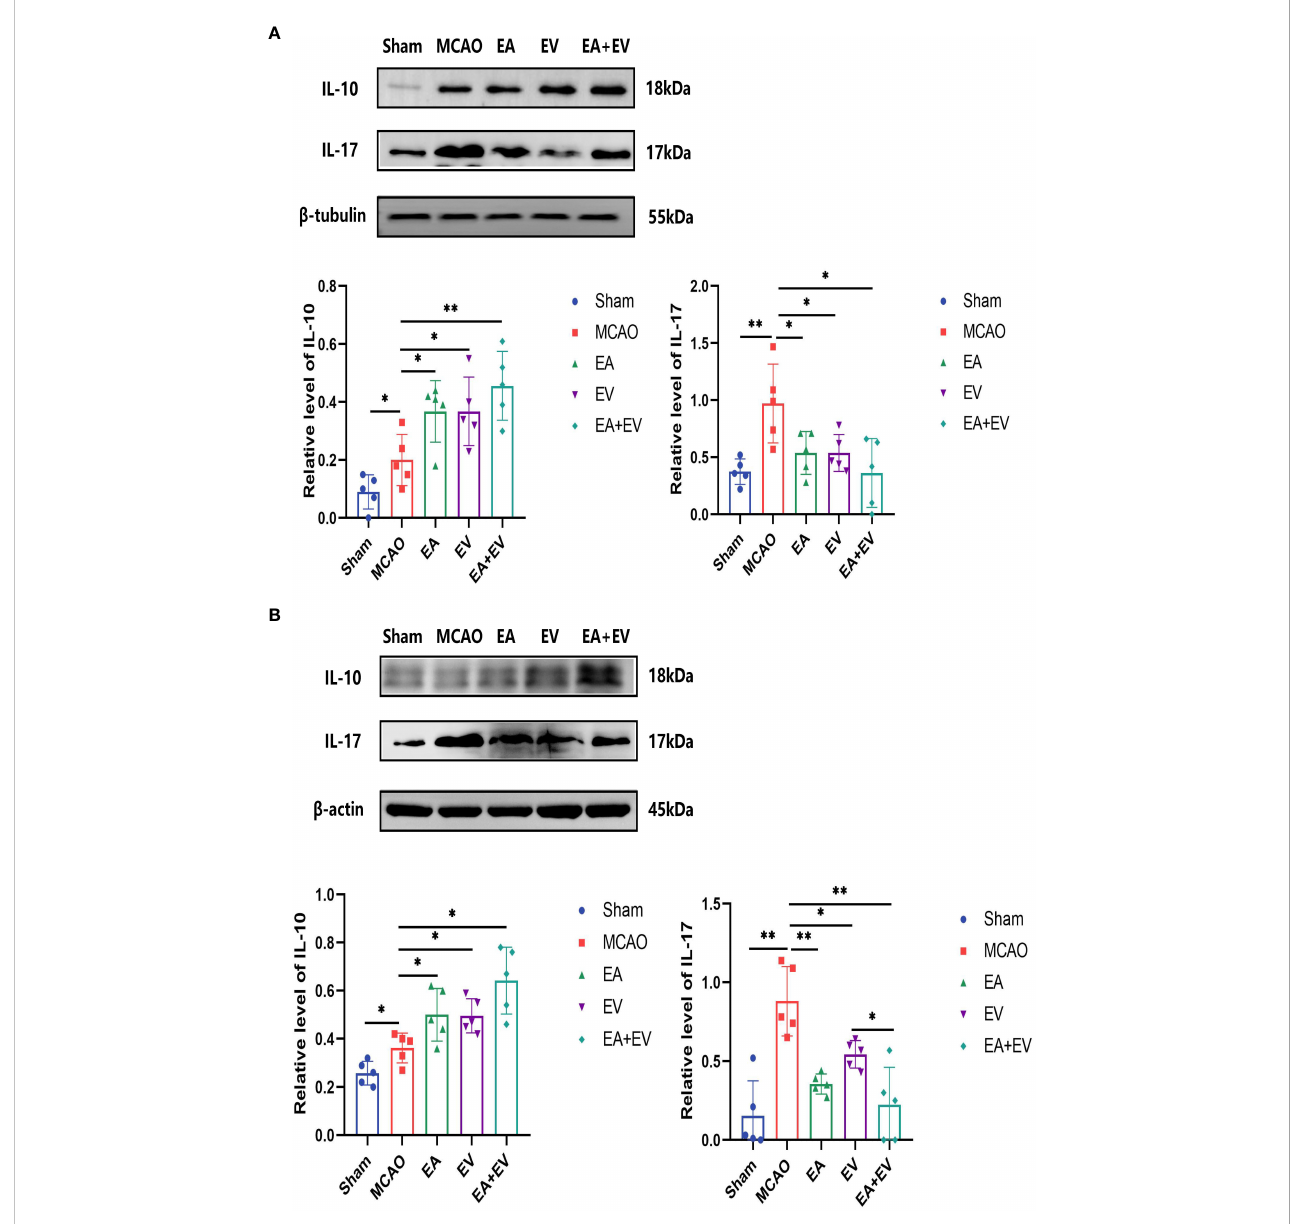
FIGURE 2 EA and iPSC-EVs treatments regulated the levels of IL-17 and IL-10 in brain and colon tissues after cerebral ischemia reperfusion. (A) The levels of IL-17 and IL-10 in brain tissues were measured by western blot, n=5/group. (B) The levels of IL-17 and IL-10 in the colon tissues were measured by western blot, n=5/group. Data were expressed as the mean±SD, * P <0.05, ** P